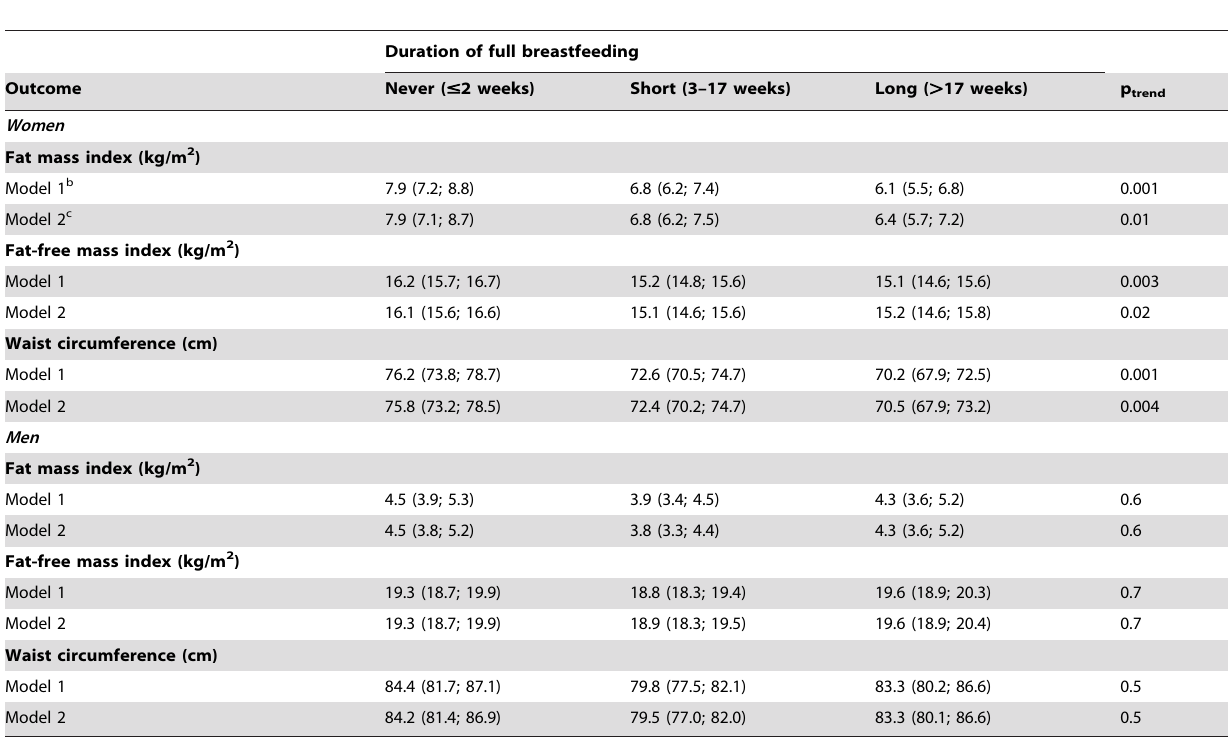
Table 3. Body composition and body fat distribution in young adulthood according to breastfeeding duration in infancy, DONALD Study (n=125 women, 108 men) a